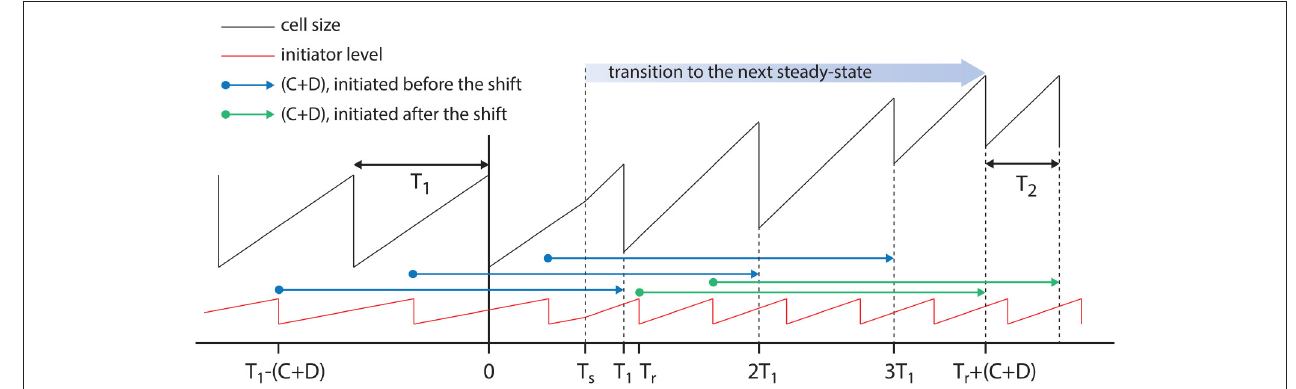
FIGURE A1 | Cell cycle and nutrient shift. Here n = 3 cell cycles overlap at the moment of nutrient shift, t = T s . In this example T 1 > T 2 and thus m ( T 1 ) < m ( T 2 ) . The three rounds of cell cycle started before nutrient shift lead to divisions at T 1 , 2 T 1 , and 3 T 1 (blue arrows). The first initiation of replication after the nutrient shift, sets up the start of the new steady-state (green arrows starting at T r